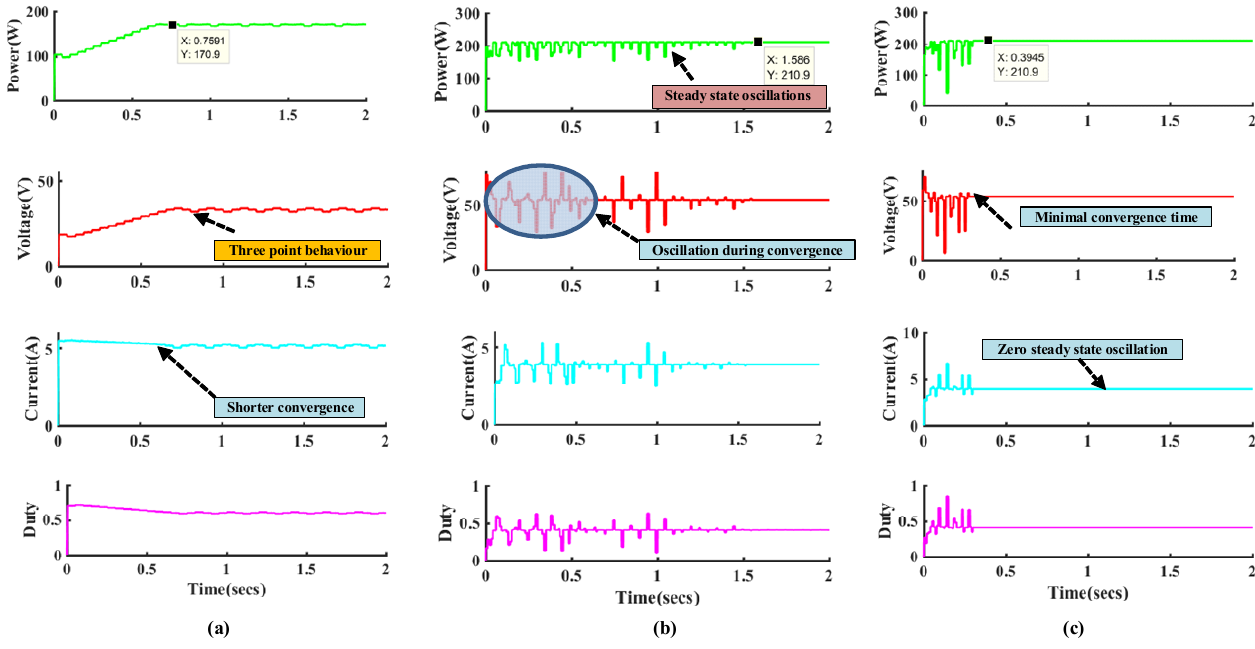
Figure 13. Simulated waveforms of ( a ) P&O, ( b ) PSO, and ( c ) SHO for Pattern 4.